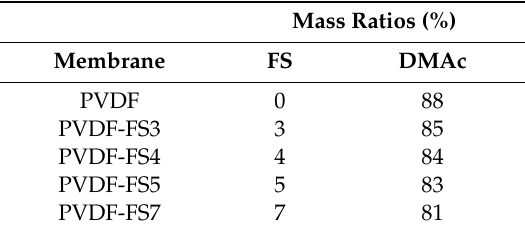
Table 1. Membrane preparation parameters followed in this study a . Mass Ratios